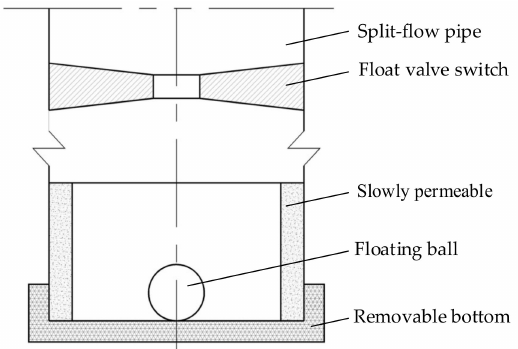
Figure 3. Main body and local details of the initial rainwater disposal system.